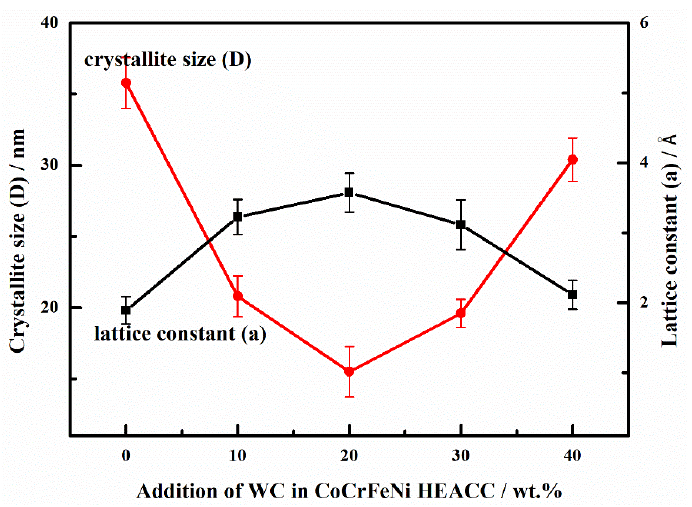
Figure 4. The grain size (D) and lattice constant (a) of the FCC phase in CoCrFeNi HEACC with increasing WC addition.